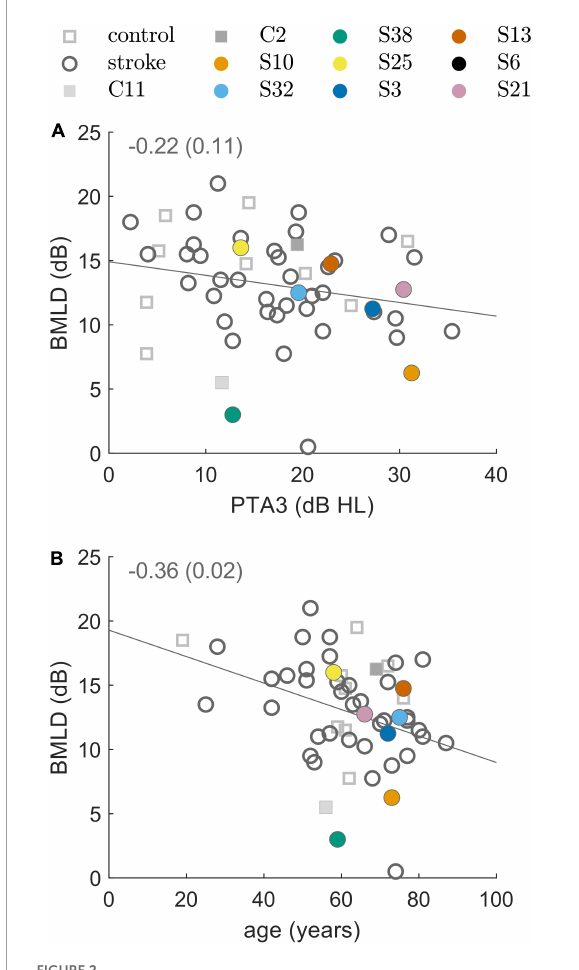
FIGURE2 Binaural masking level difference (BMLD) resulting from the binaural tone-in-noise detection experiment. BMLD over PTA3 in panel (A) and BMLD over age in panel (B) for control subjects (squares) and stroke patients (circles). The line represents a linear fit and the inset represents the correlation coefficient and the respective p -value. Selected participants are highlighted by the color coding used throughout the